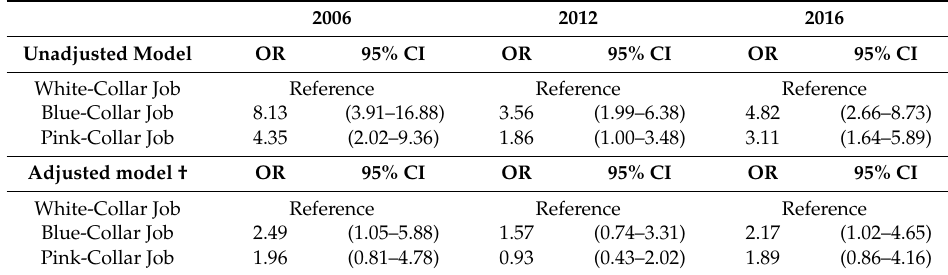
Table 3. The ORs of cognitive impairment (MMSE < 24) in female elderly over 10 years (2006, 2012, and